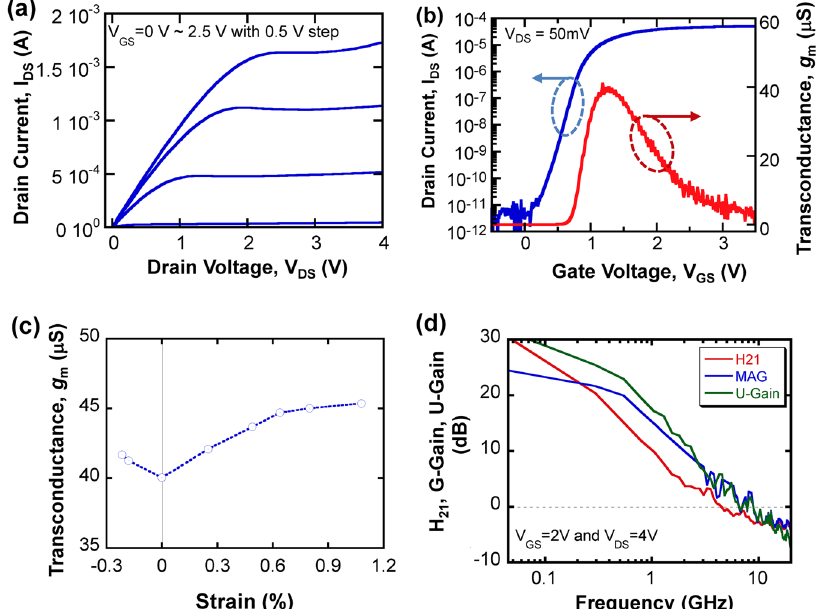
Fig. 3 Device characteristics of NMOS TFT a Drain current ( I DS ) – voltage ( V DS ) characteristics with different V GS values ranging from 0 V to 2.5 V with 0.5 V increments. b Drain current ( I DS ) and transconductance ( g m ) curves with a drain bias of 50 mV and a V GS ranging from – 0.5 V to 3.5 V. c Transconductance ( g m ) with respect to applied strain at a fi xed voltage bias point of V GS = 1 V and V DS = 3 V. d Current gain ( h 21 ) and unilateral power gain ( U -gain) as a function of frequency from 45 MHz to 20 GHz